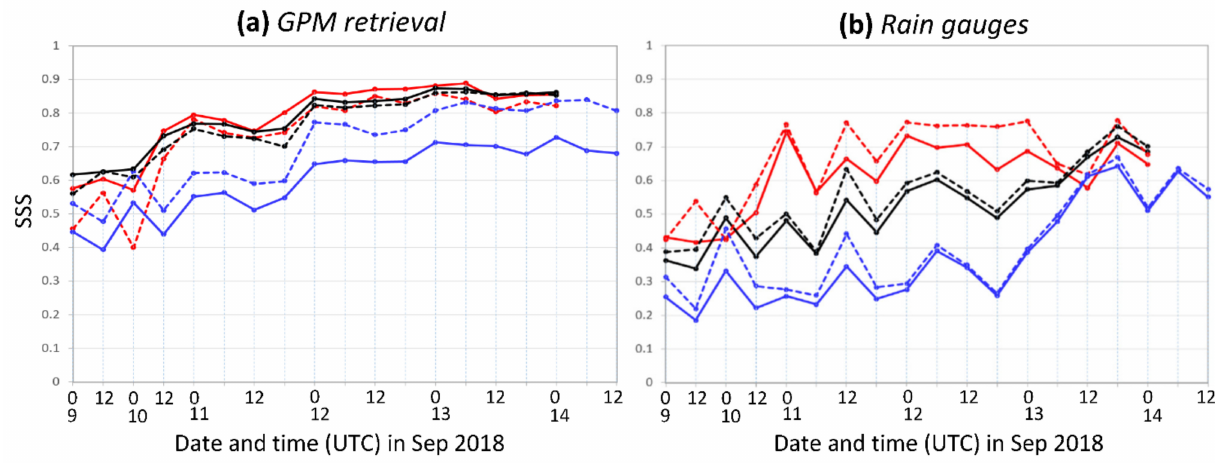
Figure 8. Similarity skill score (SSS) of 24 h QPFs targeted for 14 (red) and 15 September (blue) and 48 h QPFs for 14–15 September (black, all times in UTC) computed over the big (entire Philippine, solid) and small (Luzon island only, dashed) domains as functions of initial time from 0000 UTC on 9 September to 1200 UTC on 14 September during TY Mangkhut (2018), computed using ( a ) GPM rainfall retrievals and ( b ) rain gauge observations. Note that experiments were conducted only twice daily (at 0000 and 1200 UTC) during 9–10 September. The two domains are shown in Figure 4. The same SSS values, but computed against the 56 rain gauges over the